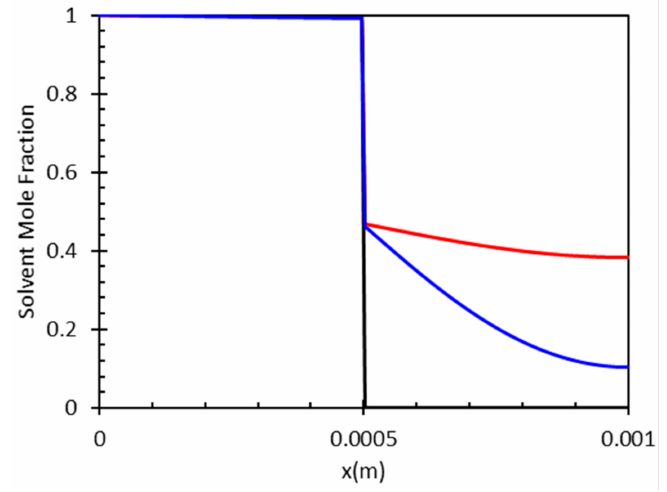
Figure 2. Solvent mole fraction distribution in a capillary at different time steps; black, blue, and red are the initial, middle, and final time steps, respectively.